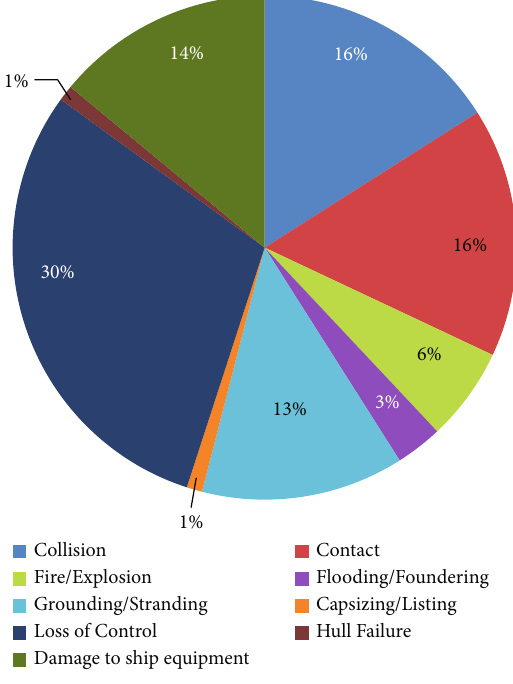
Figure 1: Causes of accidents to